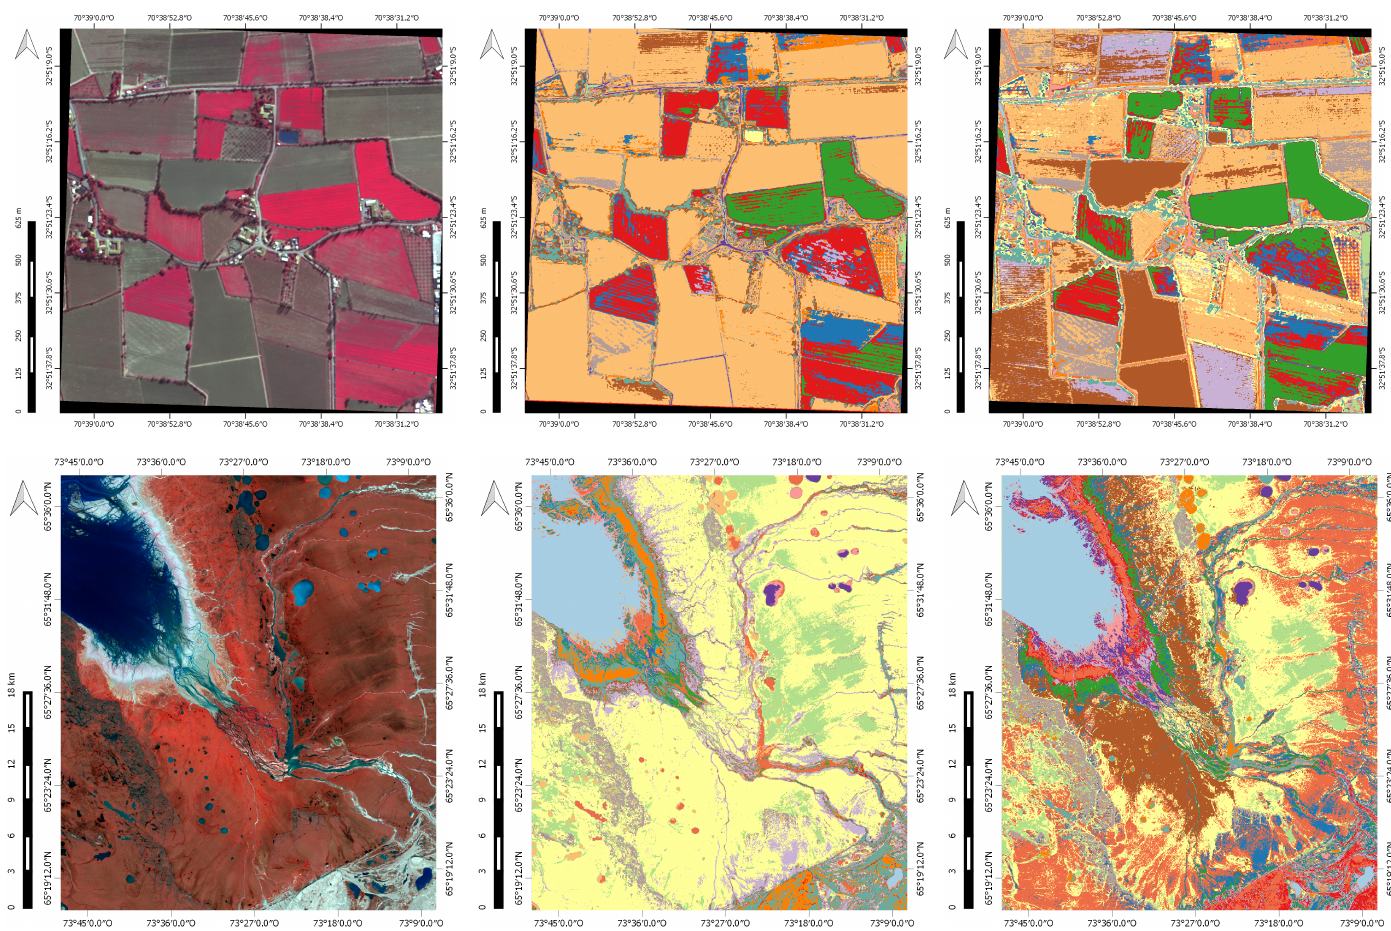
Figure 2. Results for image CHILE1 are displayed in the upper row and for CANADA1 in the lower row. First column: false color composite NIR-G-R. Results for the original method and proposed method for 15 final clusters are displayed in the second and third columns, respectively. Colors have no special